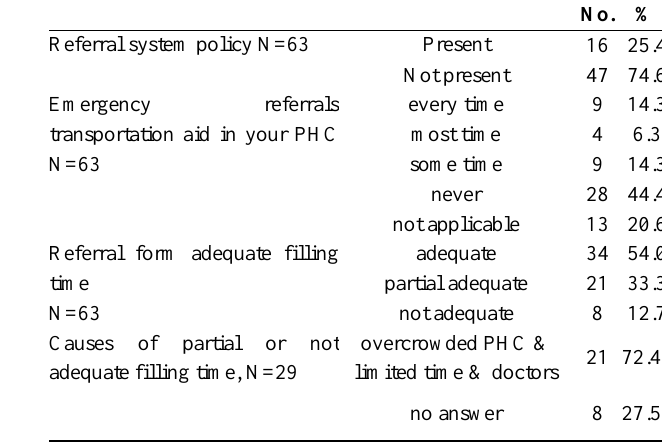
Distribution of PHC doctors according to the presence of